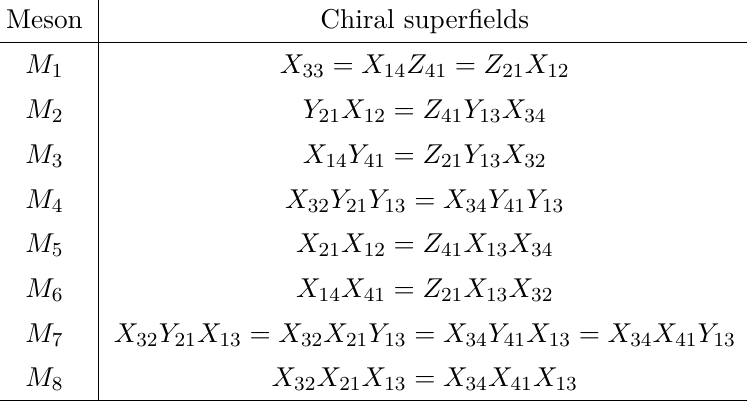
Table 1 . Generators of H 4 in terms of fields in phase